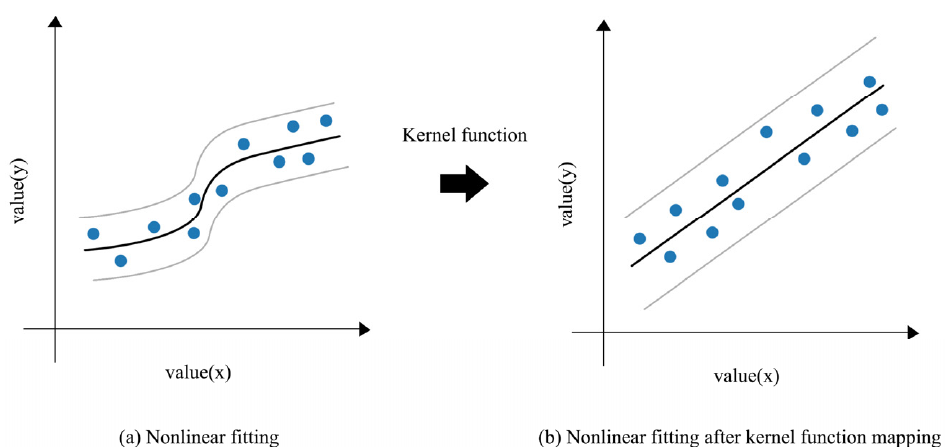
Figure 8. SVR nonlinear fitting schematic diagram.